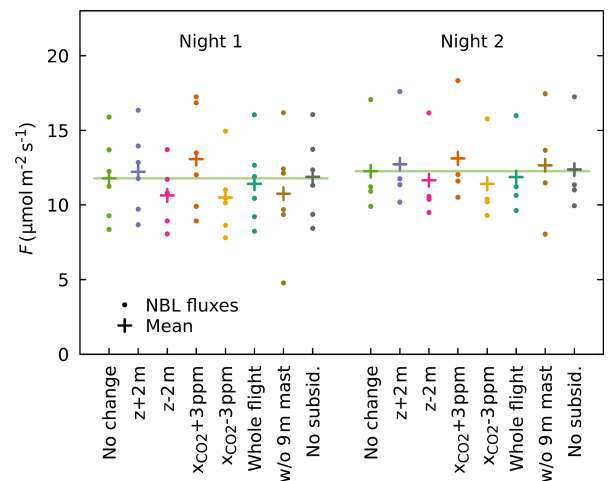
Figure 13. Sensitivity of CO 2 fluxes calculated from the NBL bud- gets to changes in calculation procedure. Dots denote the fluxes cal- culated for each flight, and crosses mark the mean of these fluxes. The lines are visual aids to facilitate comparison to the mean flux of the normal (“no change”)